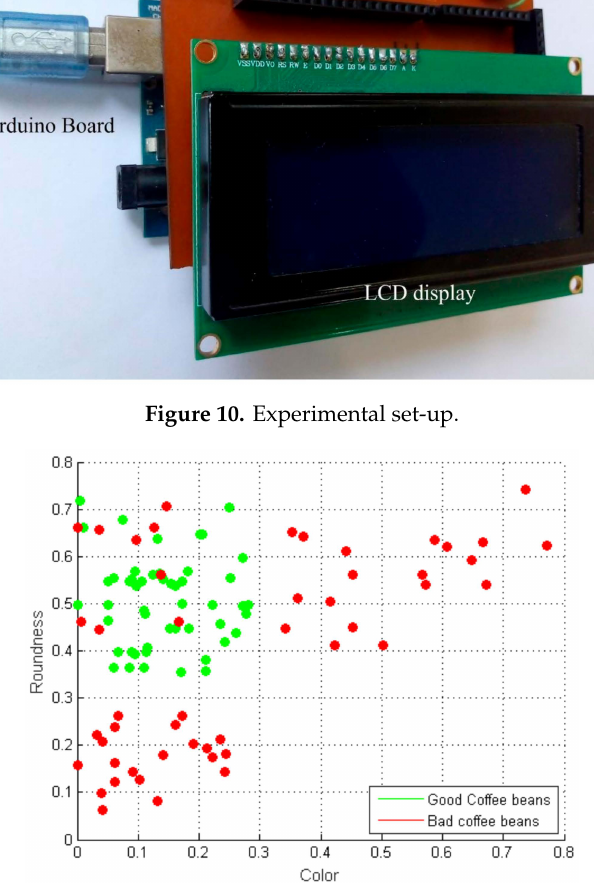
Figure 11. 2D plot of roundness and color features used for the k -nearest neighbor algorithm using the training set.